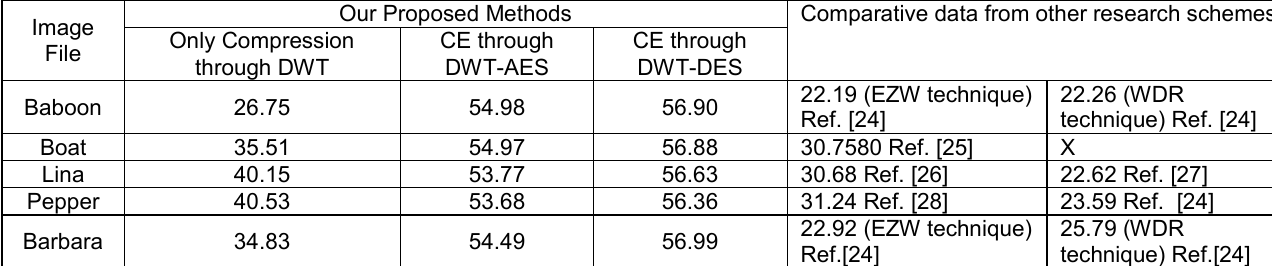
Table 3. Comparison of PSNR for different compression encryption techniques